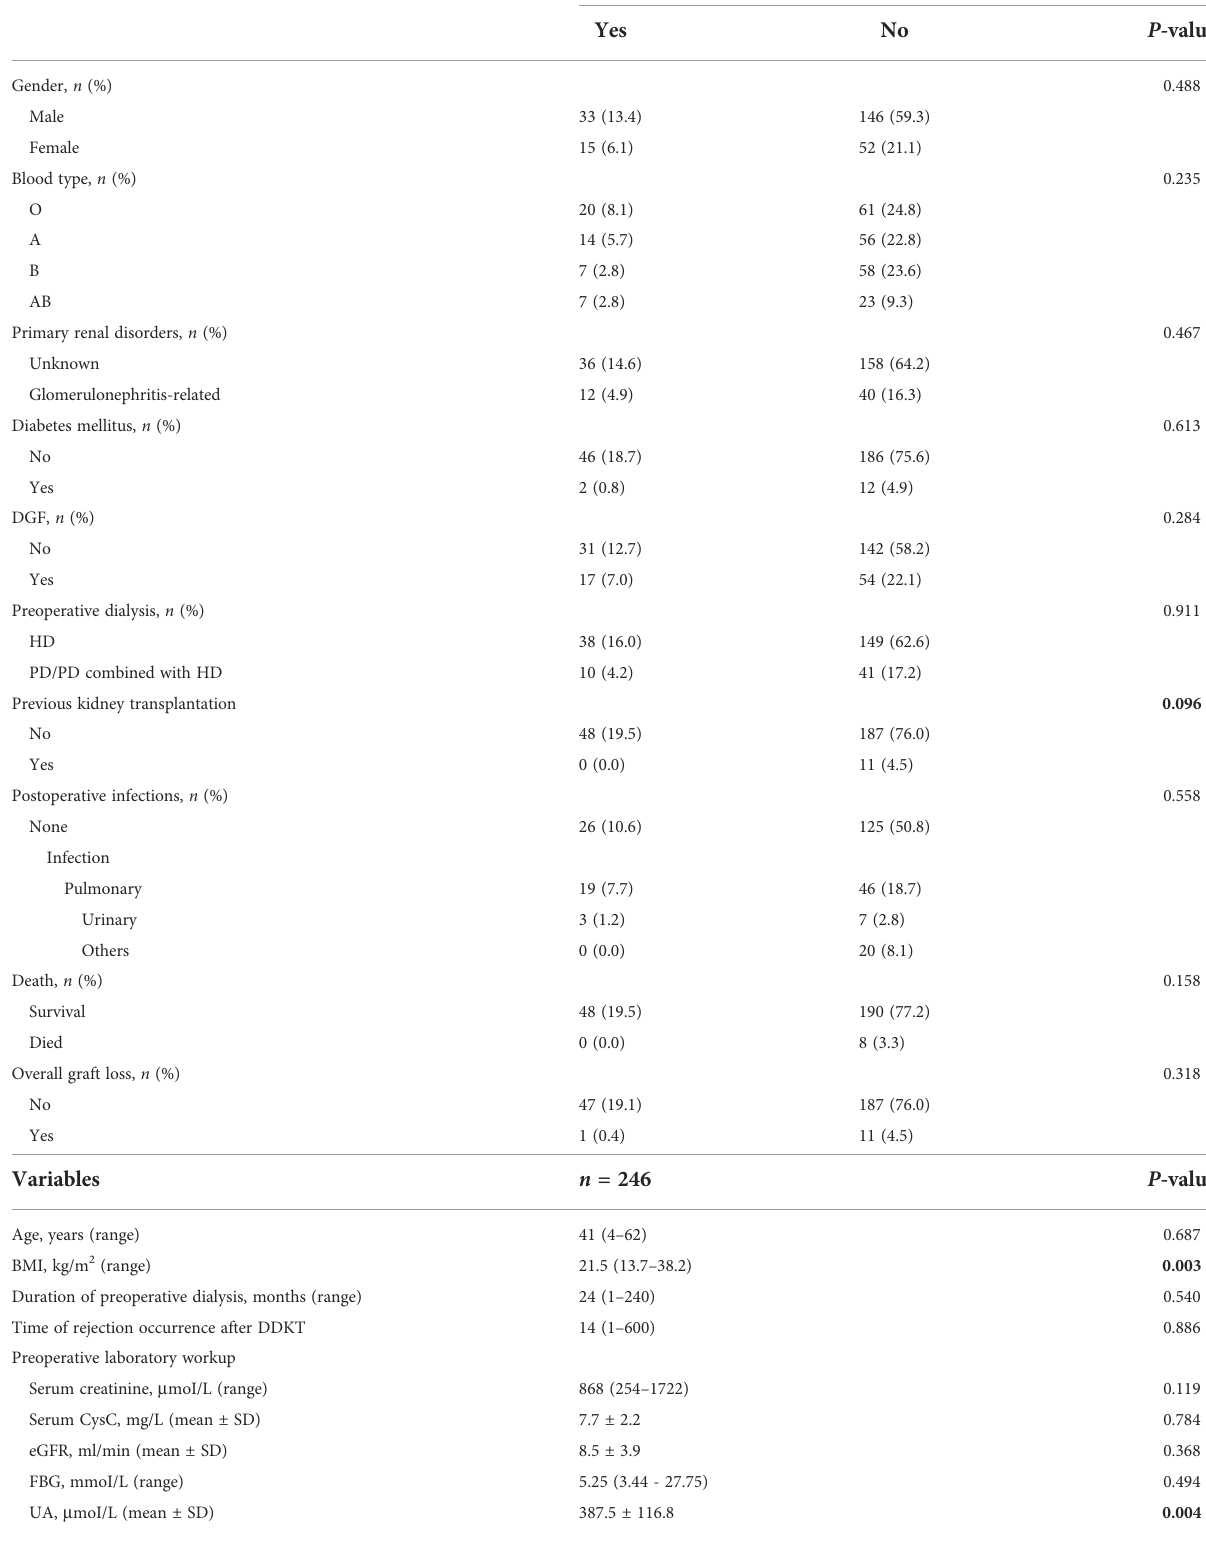
TABLE 1 Baseline characteristics of recipients and their association with treated